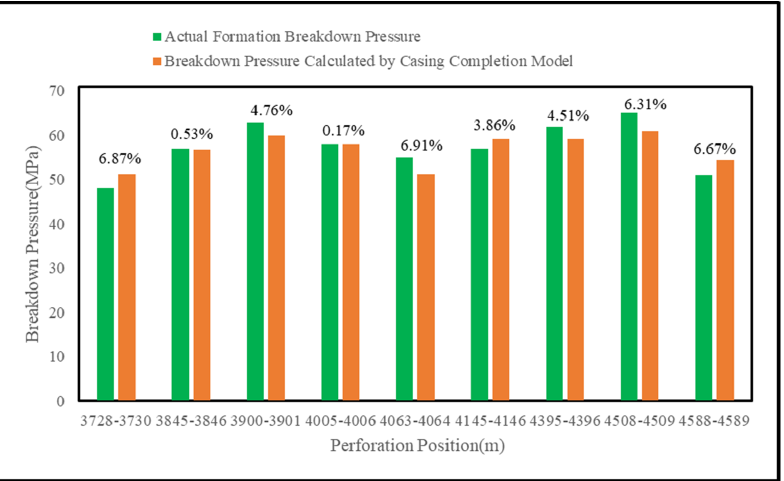
Figure 6 . Comparison between on-site construction breakdown pressure of the casing completion of Well B and breakdown pressure calculated by the well peripheral stress field model.